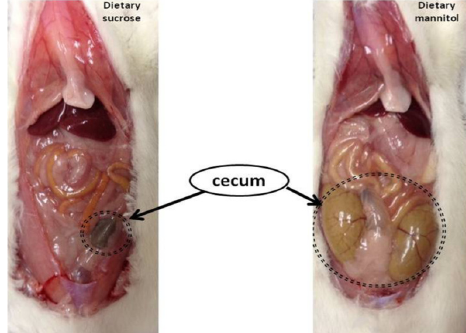
Figure 2. Differences in the size of cecum in rats fed sucrose or mannitol in the diet as digestible and indigestible sugars, respectively [70].